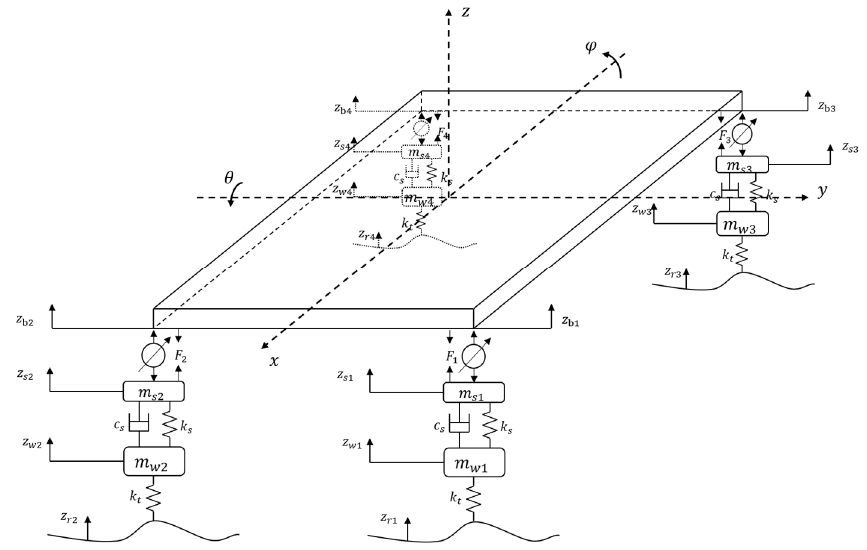
Figure 2. A simplified All-terrain vehicle model.